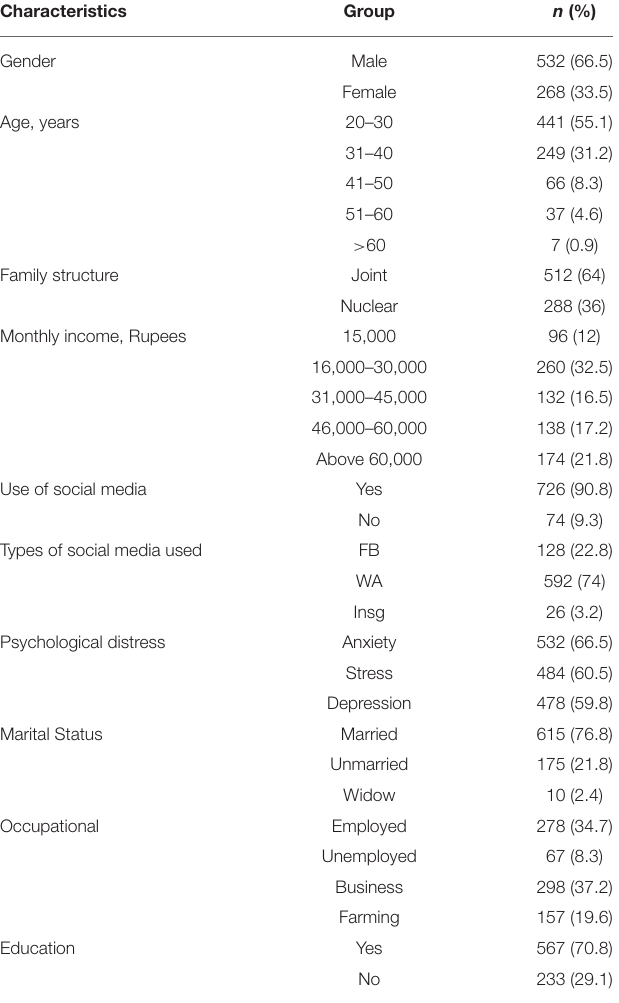
stress, and depression was 66.5, 60.5, and 59.7%, respectively, among our study